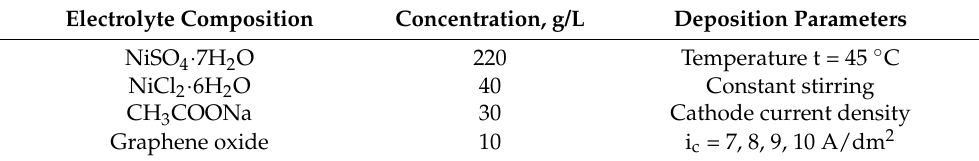
Table 1. Electrolyte composition and deposition parameters used for nickel–GO CECs. Electrolyte Composition Concentration,